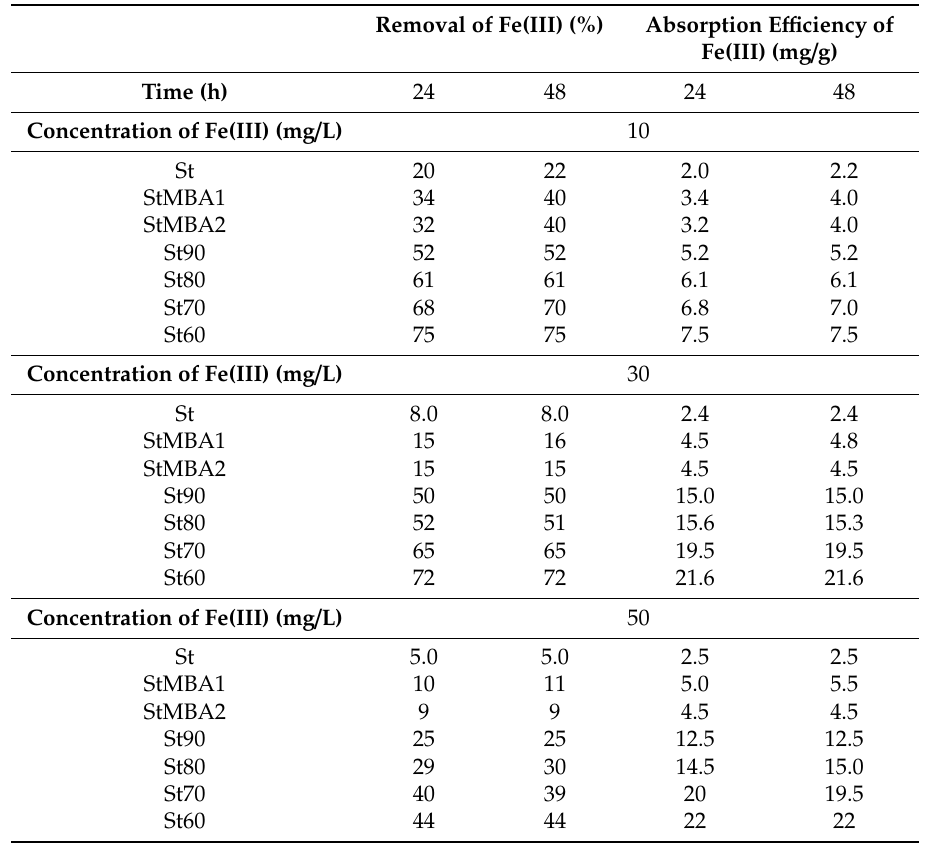
Table 2. The removal of Fe(III) (%) and adsorption e ffi ciency (mg Fe(III) / g) after 24 and 48 h for three initial concentration of Fe(III) 10, 30 and 50 mg / L for St, StMBA1, StMBA2 and starch SAPs with di ff erent amount of